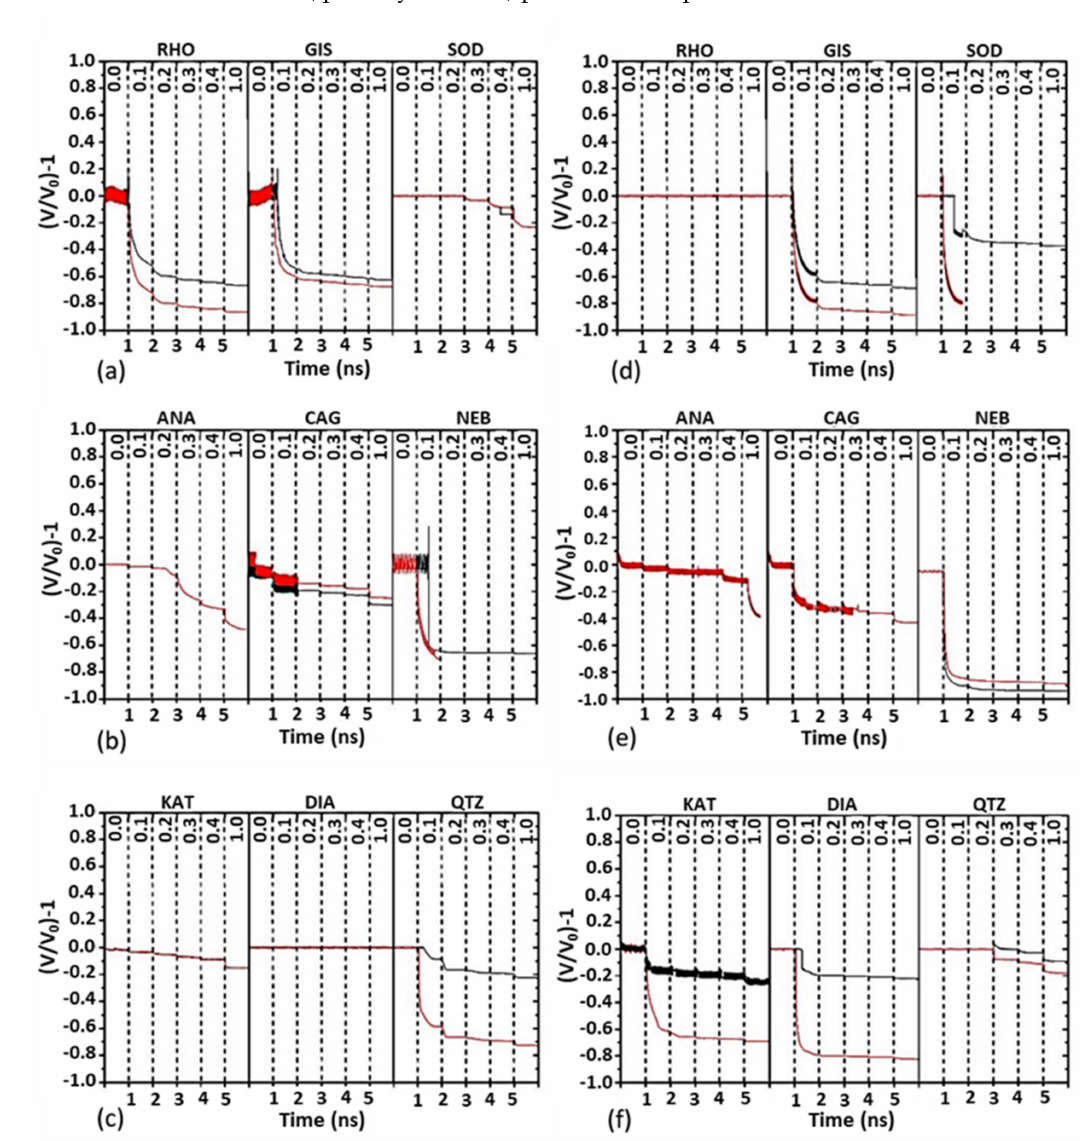
Figure 3. CMD calculation of the variation of the volume, normalized with respect to the average volume at zero pressure, as a function of time and pressure for the nine ZIF topologies considered in this work: ( a – c ) with the HMeIm ligand, ( d – f ) with the HEtIm ligand. Black: infinite structure, red: cluster. The pressure in GPa is indicated in the upper part of each